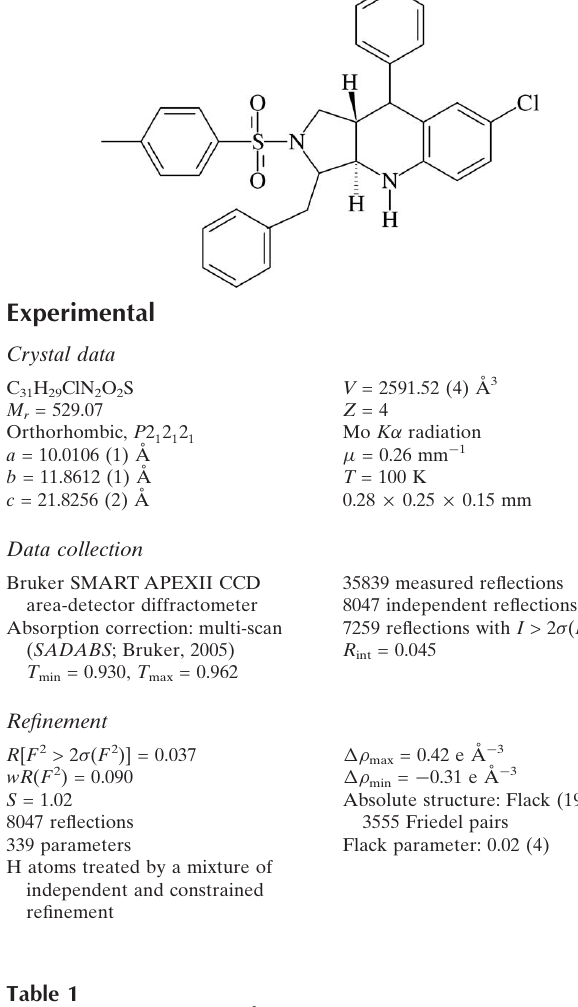
Hydrogen-bond geometry (A˚ , (cid:2)